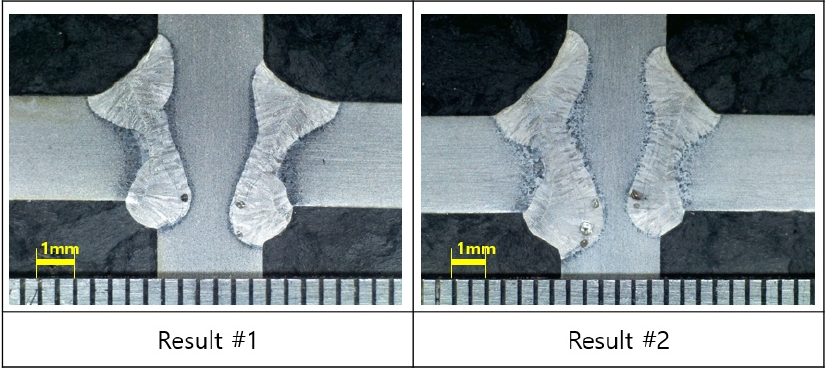
Figure 16. Final result of 3.0 mm thickness Invar.